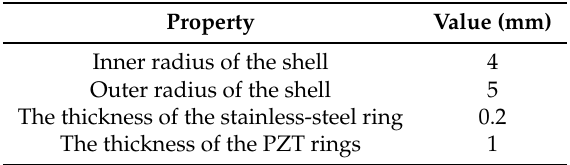
Table 1. The final dimensions of each part of the